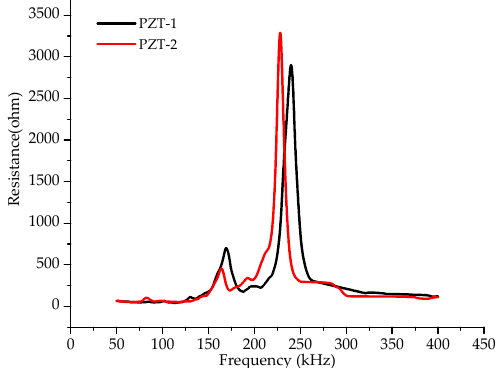
Figure 6. The resistance signatures at the frequency range from 50 kHz to 400 kHz of the PZT-1 and PZT-2 transducers at the perfect bonding state.